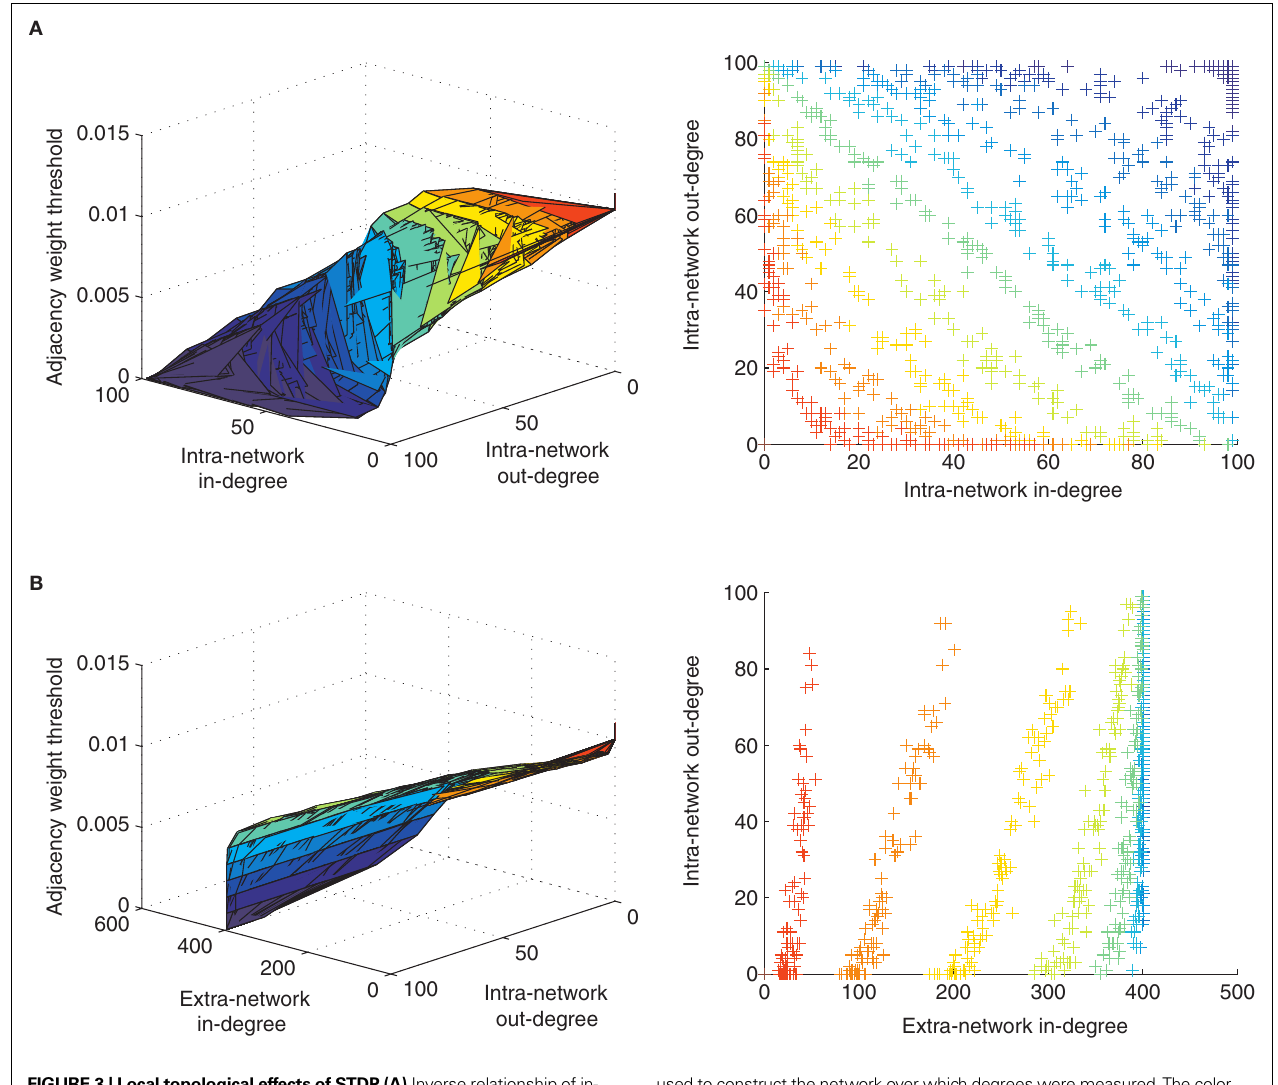
FIGURE 3 | Local topological effects of STDP. (A) Inverse relationship of in- degree versus out-degree of intra-network connections for each neuron in a network after 10 s of STDP across multiple weight thresholds for network connections. Colors in left and right panels correspond to a weight threshold